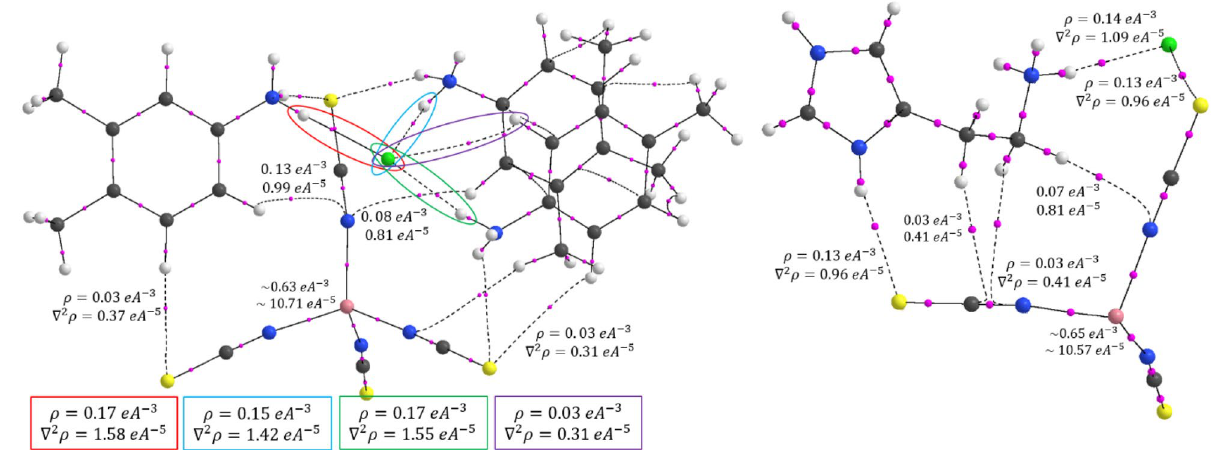
Figure 15. The bond critical point (bcp) map with their topological